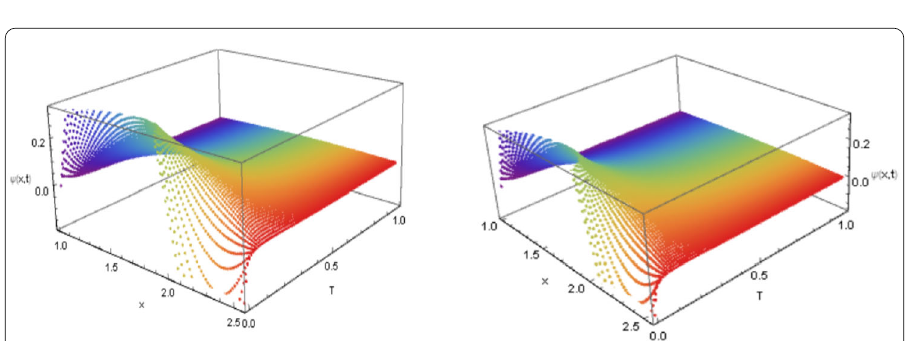
Figure 3 Surface plot to Example 1 at β = 1 exact solution (left) and using FVSF (right)